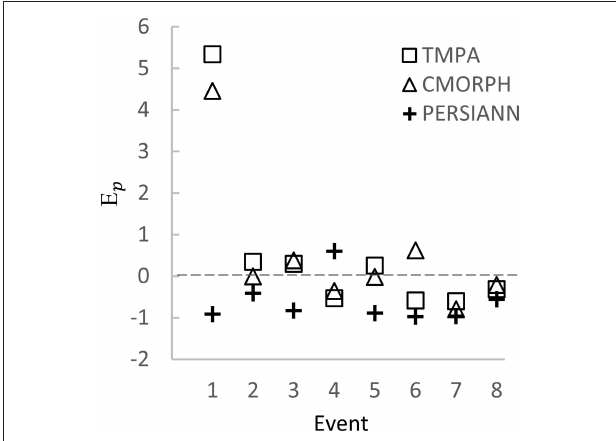
FIGURE 8 | Mean peak streamflow error of TMPA, CMORPH, and PERSIANN with respect to gauge-simulated